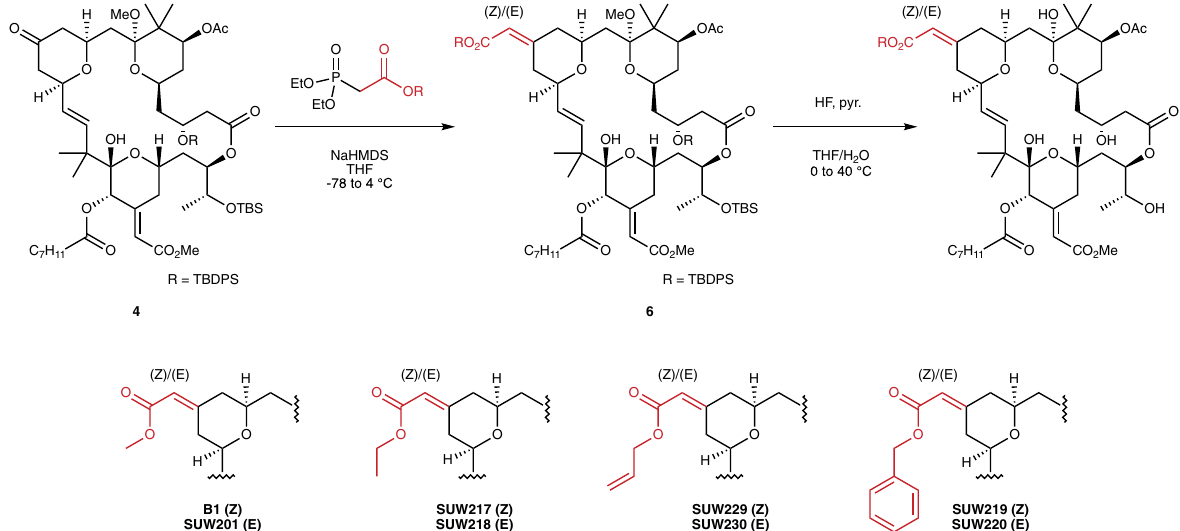
Fig. 3 Synthesis of C13 enoates via HWE ole fi nation of the C13 ketone. Detailed procedures for speci fi c transformations can be found in the Supplementary Methods.